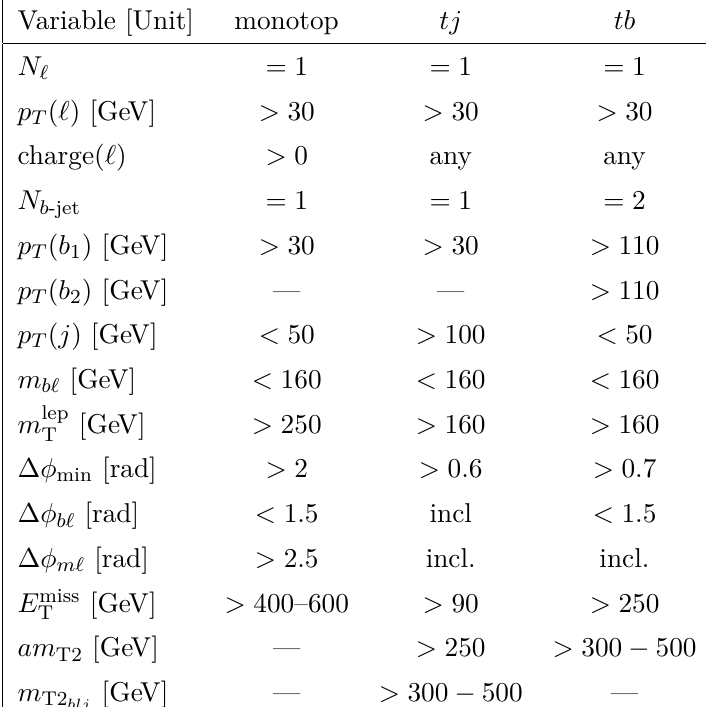
— ( j ) is the transverse momentum of T